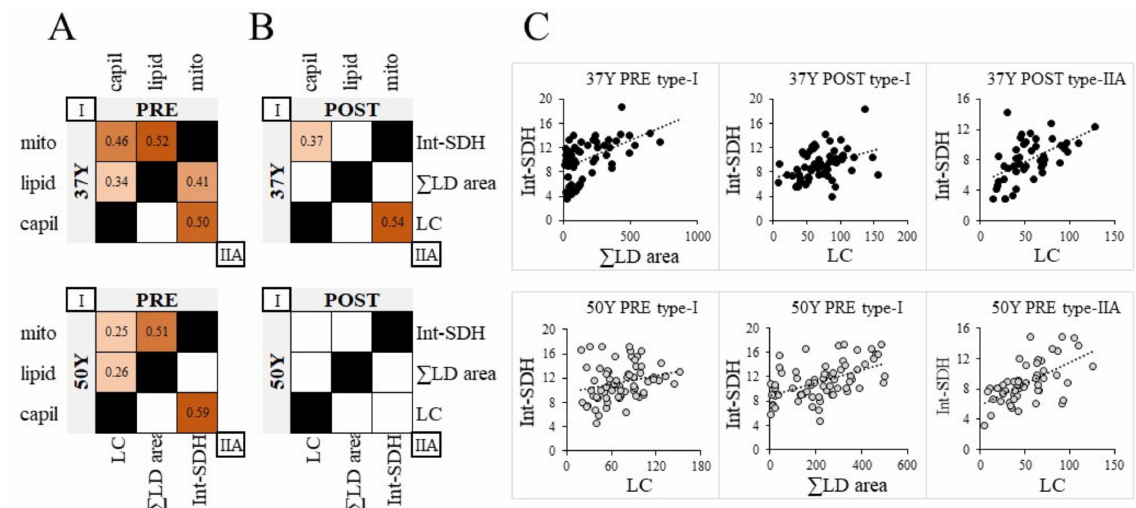
Figure 5. Coordination between microvascular, lipid, and mitochondrial processes. Linear Pearson’s correlations between global indices of capillarization (LC, the total length of contact with capillaries), intramyocellular lipids ( ∑ LD area, the sum of LD area), and mitochondrial oxidative capacity (Int- SDH) for type I (upper left) and type IIA (lower right) fibers of ( A ) PRE and ( B ) POST vastus lateralis of 37Y (top) and 50Y (bottom) runners. Correlations coefficients ( r ) are indicated when p < 0.05. ( C ) Examples of linear regressions between Int-SDH, ∑ LD area, and LC for 37Y (top) and 50Y (bottom)